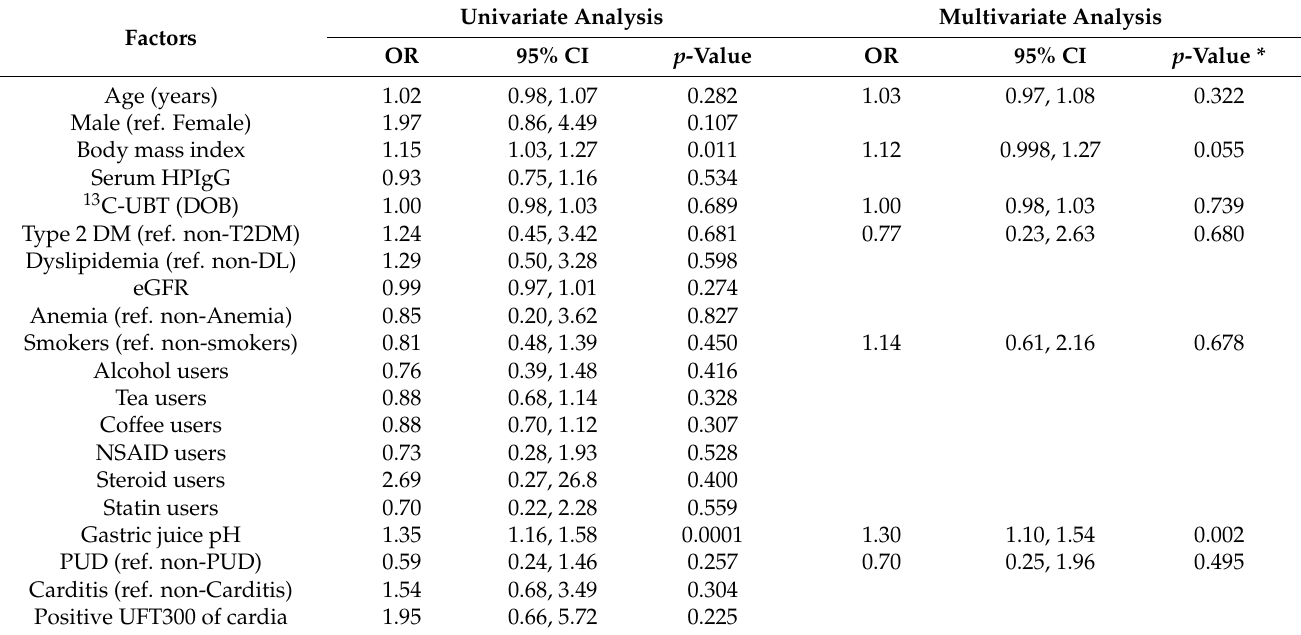
Table 1. Logistic regression analysis to factors affecting the ILTHPI.